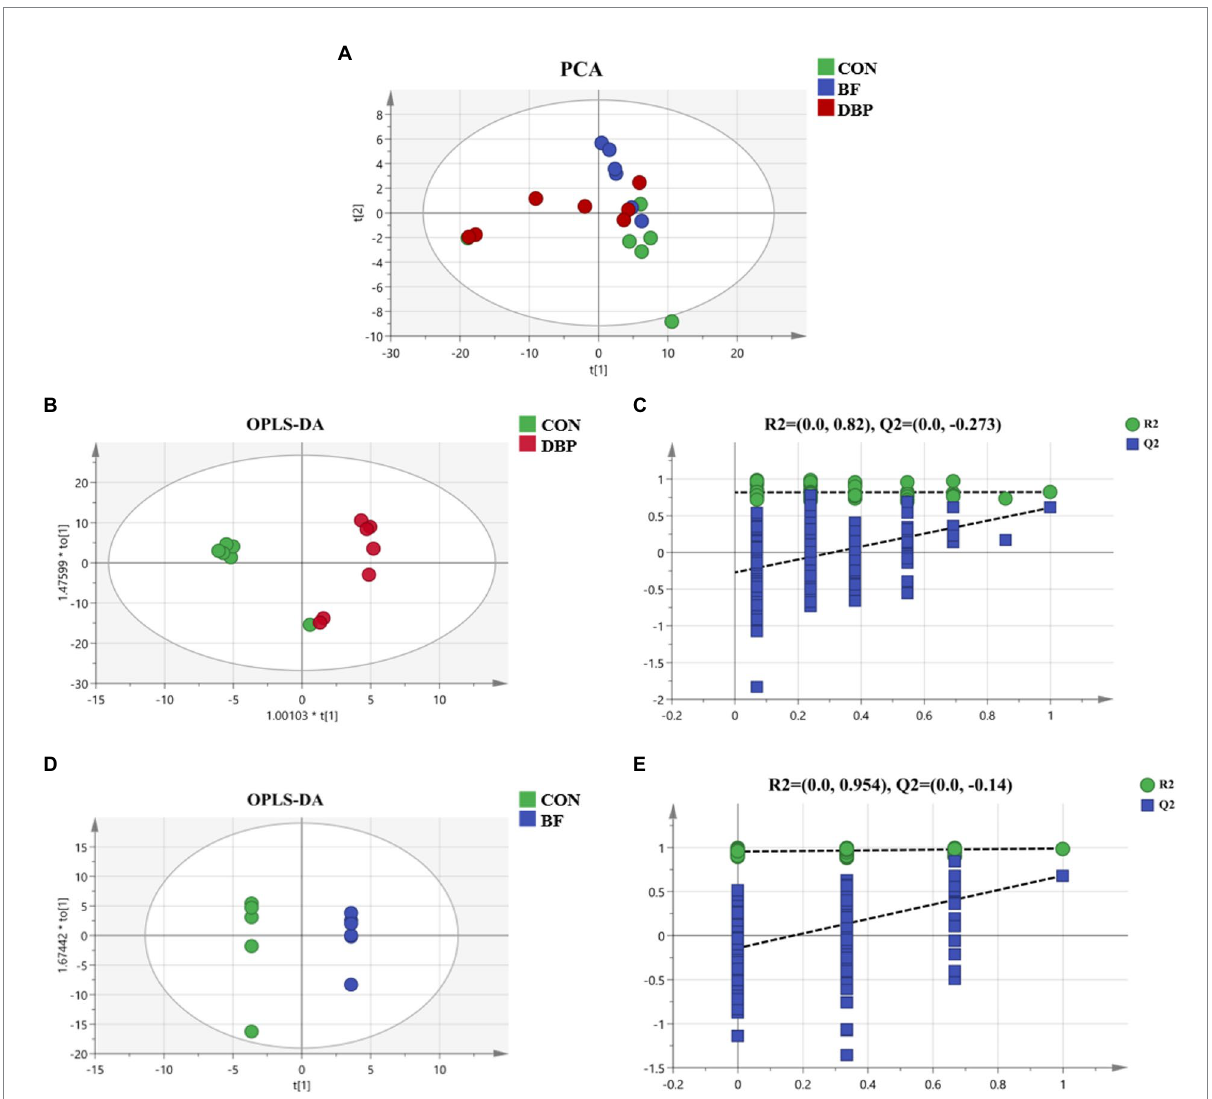
FIGURE 1 Effects of defatted black soldier fly larvae protein (DBP) and black soldier fly larvae fat (BF) on serum metabolites in dogs. Principal component analysis (PCA) of serum metabolites among the three groups (A) . Orthogonal partial least squares discriminant analysis (OPLS-DA) plot of serum metabolites after DBP (B) , and BF (D) , administration in dogs. Response permutation testing (RPT) derived from the DBP group (C) , or the BF group (E) , compared with the CON